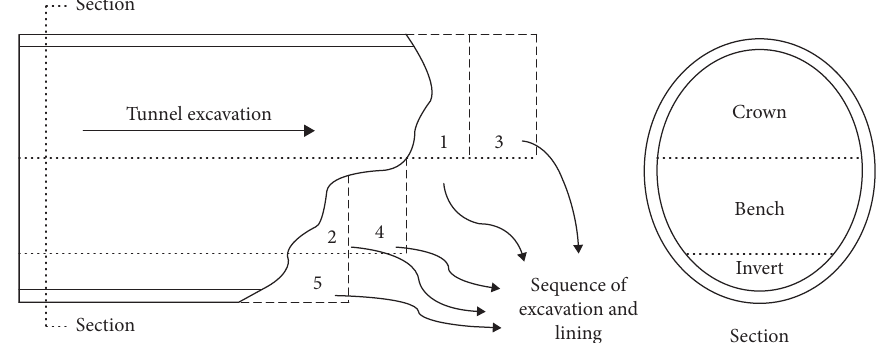
Figure 1: Example of excavation phases of the Sequential Excavation Method